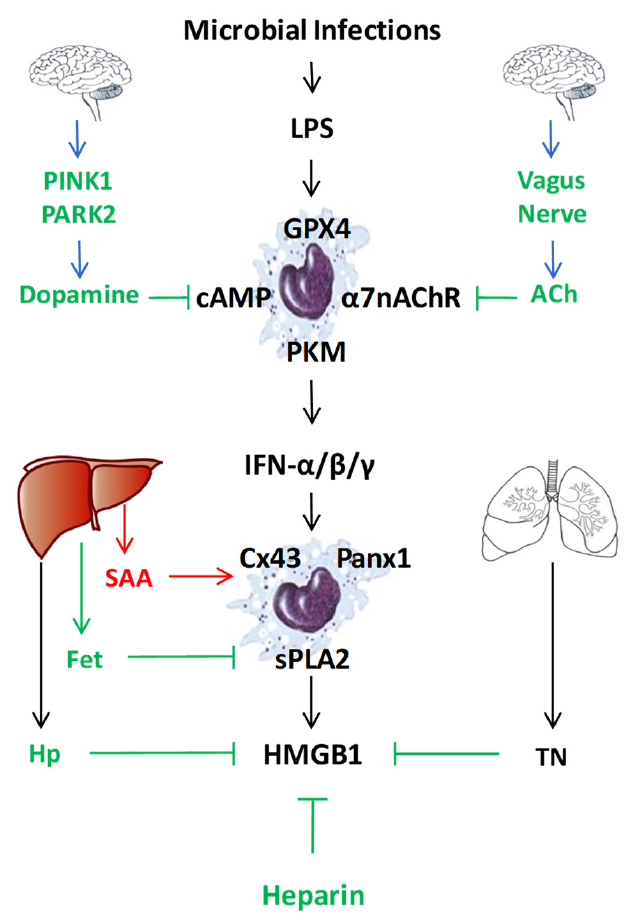
Figure 3. Endogenous regulators of LPS-induced HMGB1 release or action. To regulate the LPS- induced HMGB1 release or action, mammals have evolved multiple regulatory mechanisms that include neuro-immune pathways, liver-derived acute-phase proteins (e.g., SAA, Fetuin-A (Fet), Haptoglobin (Hp)), as well as other endogenous proteins (e.g., tetranectin (TN)) or polysaccharides (heparin).